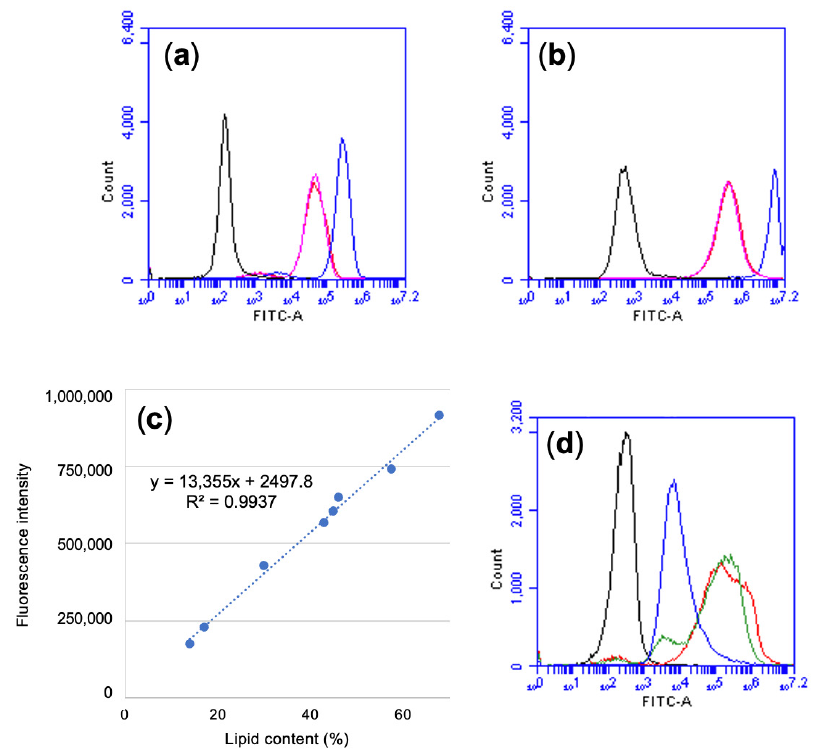
Figure 4. ( a , b ) FACS histograms showing different BODIPY 493/503 concentrations on ATCC 20509 samples collected at 24 h ( a ) and at 90 h ( b ) of the production process. Black line = unstained sample; pink line = 0.75 µ M BODIPY 493/503; red line = 1.5 µ M BODIPY 493/503; blue line = 7.5 µ M BODIPY 493/503. ( c ) Calibration curve correlating the BODIPY 493/503 fluorescence intensity with lipid content (expressed in % on dry weight) detected by colorimetric method. ( d ) FACS histogram showing BODIPY 493/503 fluorescence in different strains. Black line = unstained sample; blue line = DBVPG 6630; green line = ATCC 20508; red line = ATCC 20509.